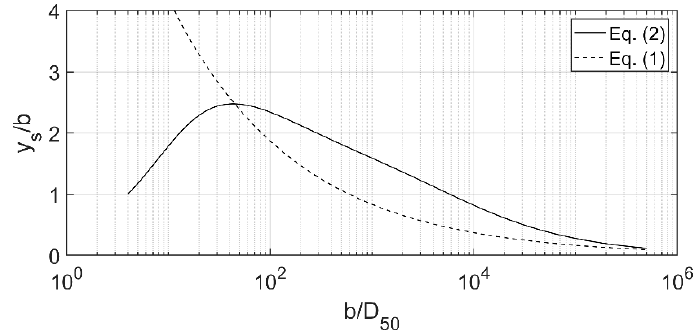
Figure 1. Comparison between the Florida Department of Transportation (FDOT) equation and the Colorado State University (CSU) equation.